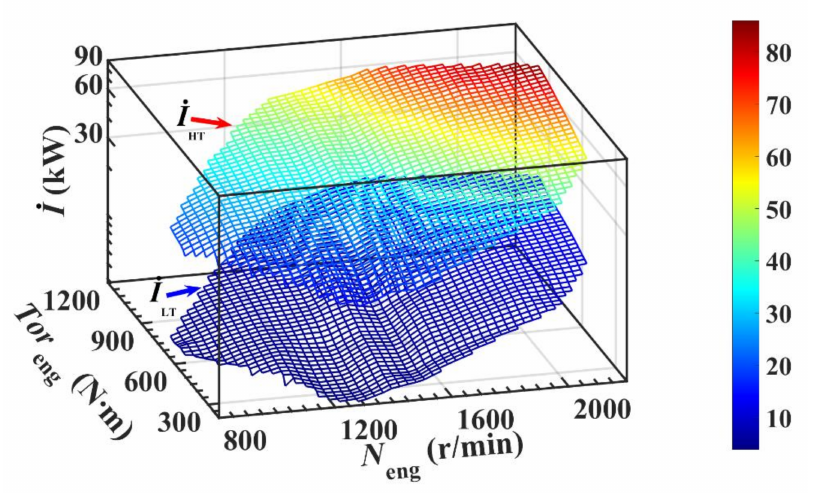
Figure 9. Dynamic response characteristics of HT loop and LT loop exergy destruction under full operating